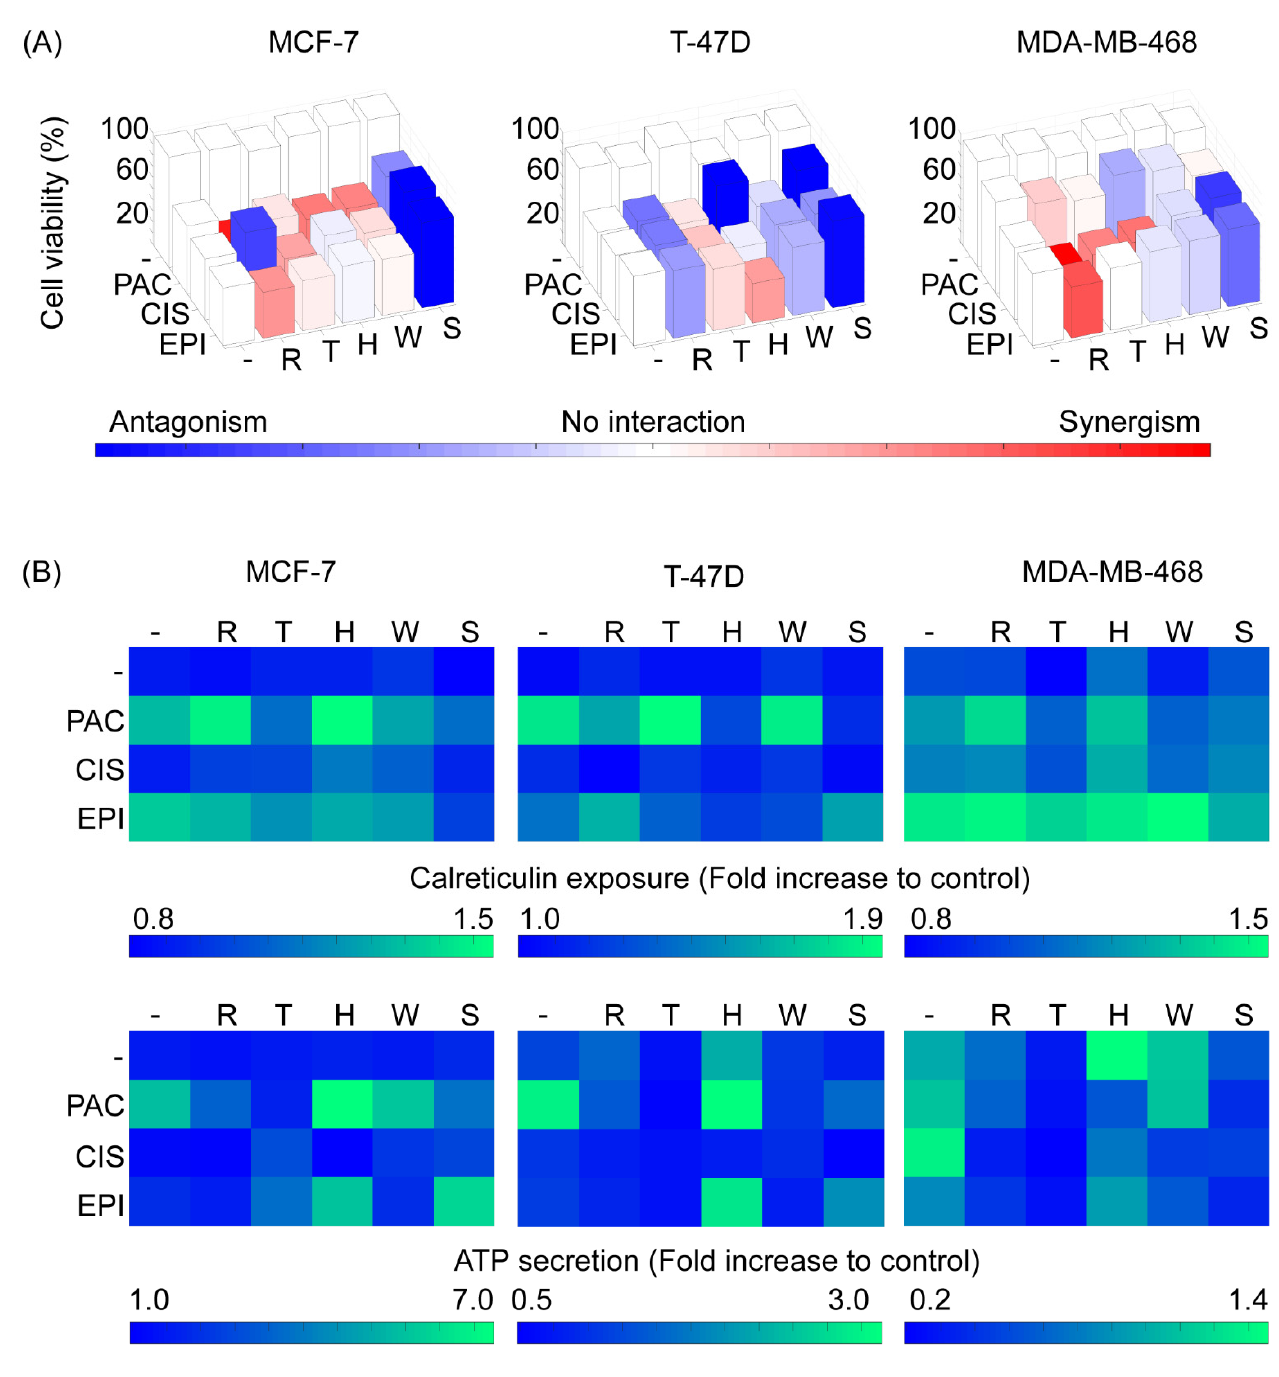
Figure 3. Cell line-specific profiles of cytotoxicity and cell death immunogenicity arise from the interactions between autophagy regulators and chemotherapeutic perturbations. ( A ) Cytotoxicity profiles for each chemotherapeutic drug and autophagy regulator combination for each cell line. Single perturbations are represented as white bars, while double perturbations are colored from blue (strong antagonism) to red (strong synergism) passing through white (no interaction). ( B ) Calreticulin exposure upon 24 h and ATP secretion upon 72 h of single and combined treatments. CIS: cisplatin, EPI: epirubicin, H or HCQ: hydroxychloroquine, PAC: paclitaxel R: rapamycin, S: Spautin-1, T: Torin-2, W: wortmannin. Regarding paclitaxel, in the MCF-7 cell line, this drug displayed a strong synergism with rapamycin, and a slighter synergism with Torin-2, HCQ and wortmannin. From